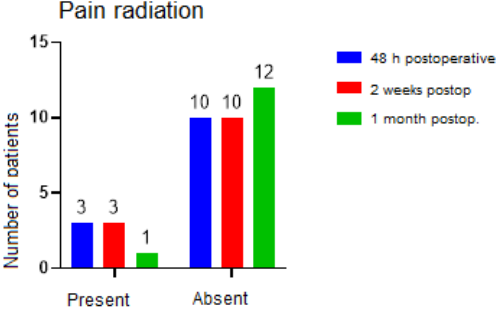
Figure 12. Pain Figure 12. Pain radiation.